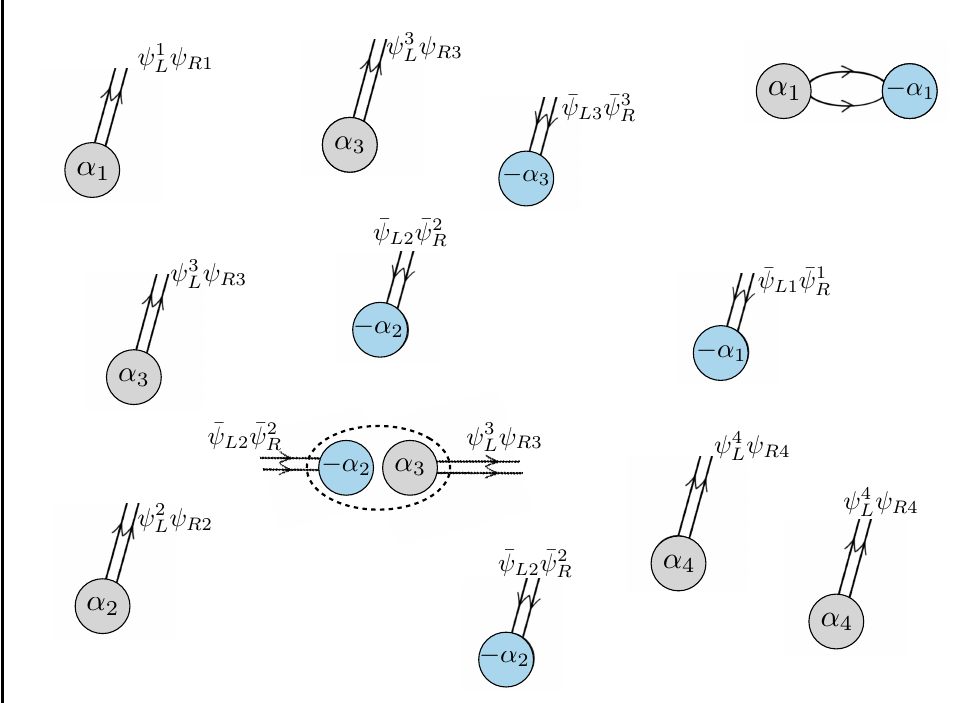
Figure 12 . Dilute gas of topological configurations in the weak coupling regime obtained by using graded partition function. Due to Ω 0 background, each species of monopole-instanton has F exactly two fermionic zero modes. Naively, each monopole-event violates the maximal abelian chiral symmetry U(1) N f − 1 . However, this is not the case because of the intertwining of chiral